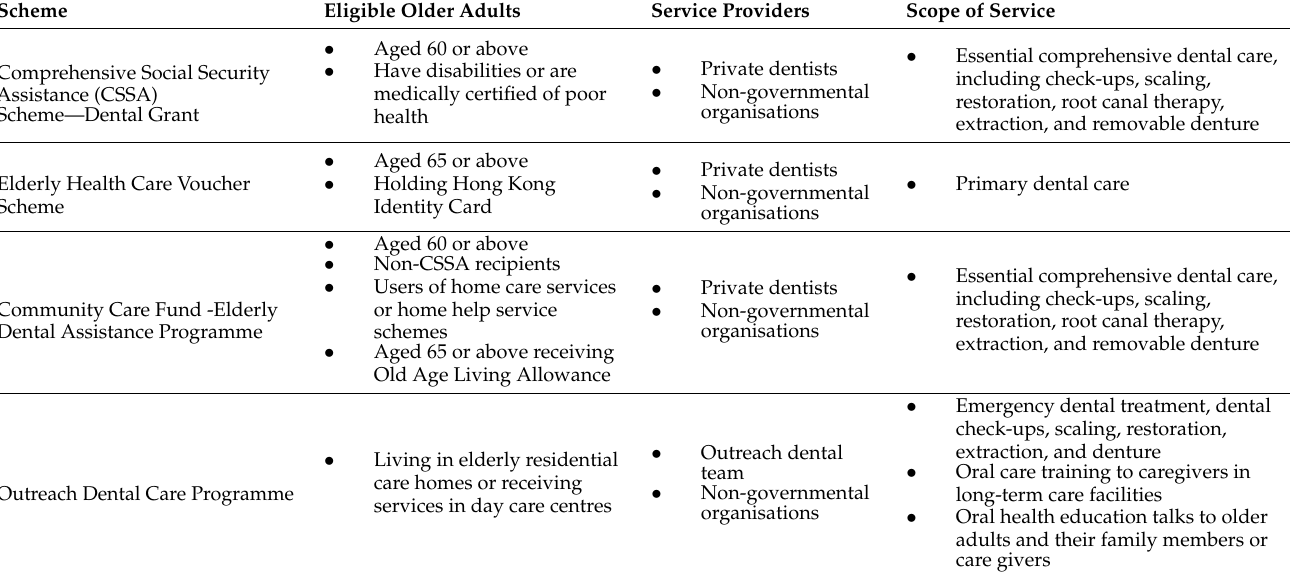
Table 1. The four government-subsidized dental service schemes for older adults in Hong Kong. Scheme Eligible Older Adults Service Providers Scope of